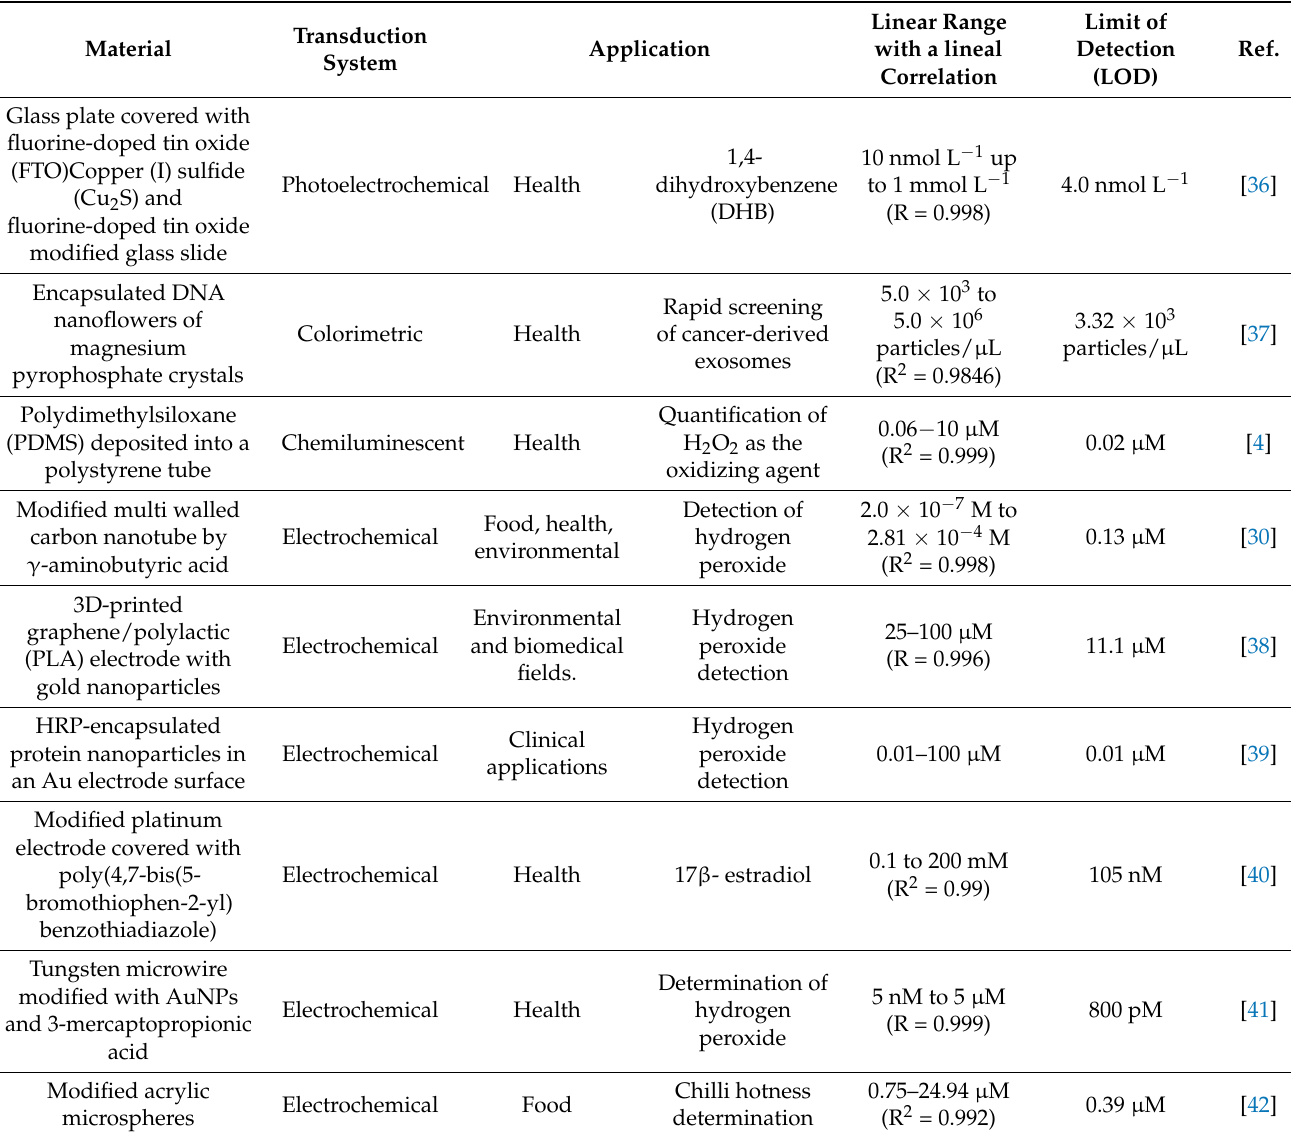
Table 1. Horseradish peroxidase